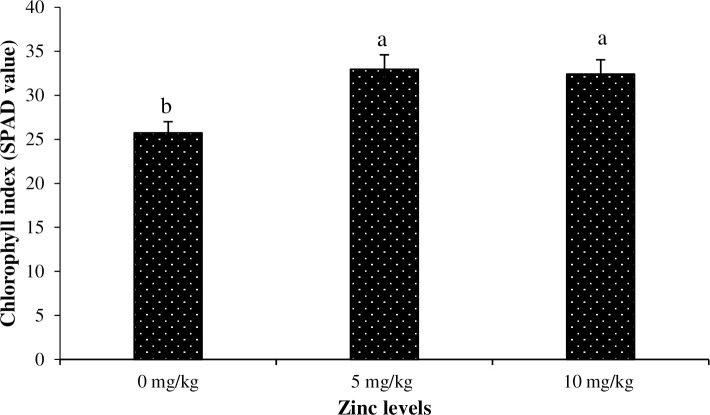
The influence of different Zinc (Zn) levels on chlorophyll index of Basil (Ocimum basilicum L.).The vertical bars are means ± standard errors. Any two means having different letters are statistically different from each other (p < 0.05).